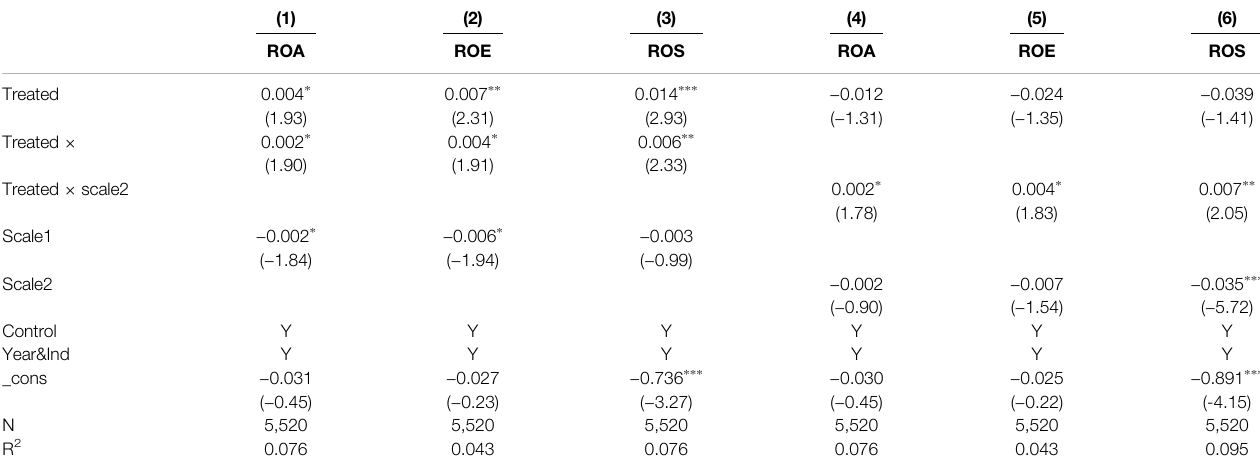
TABLE 7 | Impact of the new Environmental Protection Law on the performance of enterprises of different